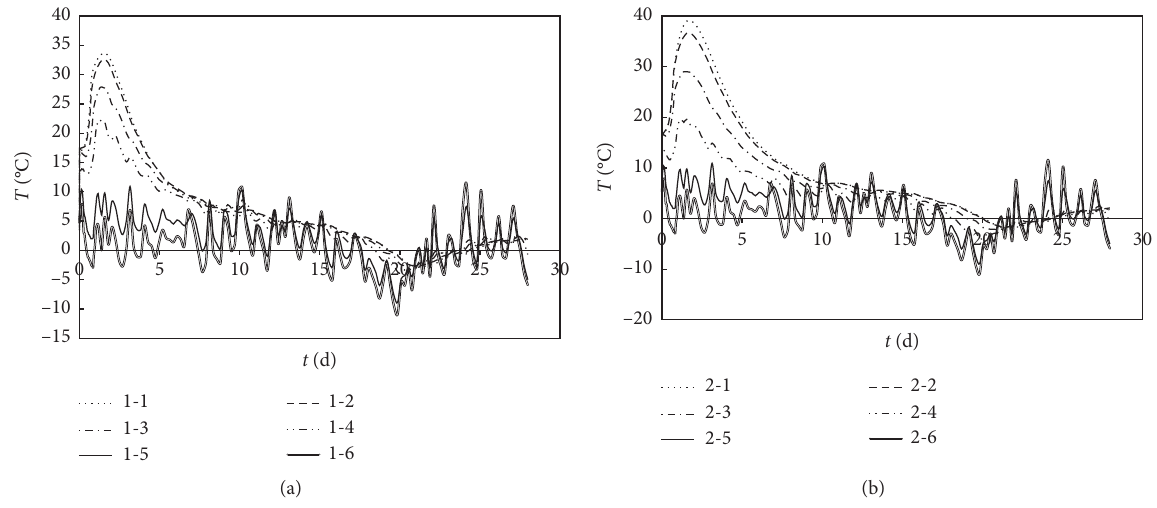
Figure 6: Test curves of temperature measurement of the core concrete. (a) SYZ-1 column. (b) SYZ-2 column.